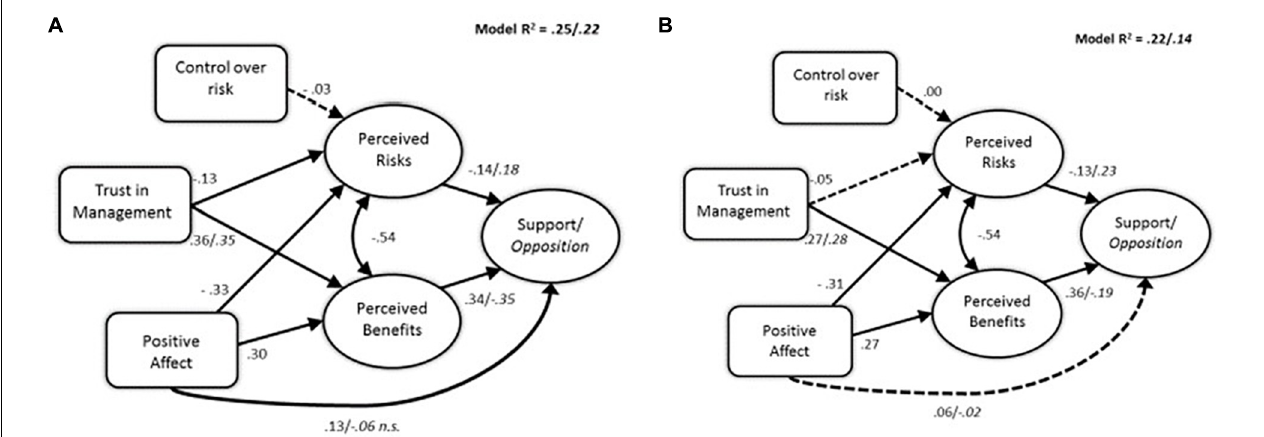
FIGURE 2 | Structural equation model coefficients estimated using unweighted data (A) and weighted data (B) imputed with linear interpolation for both support and opposition. Where different, the opposition model coefficients are in italics. Bolded lines represent pathways significant at the p < 0.01 level for both models, dotted lines represent non-significant paths in both models. Discrepancies in path significance between models is noted with n.s. following the appropriate path coefficient. Observed (directly measured) variables are in rectangles, while latent variables are in ovals.